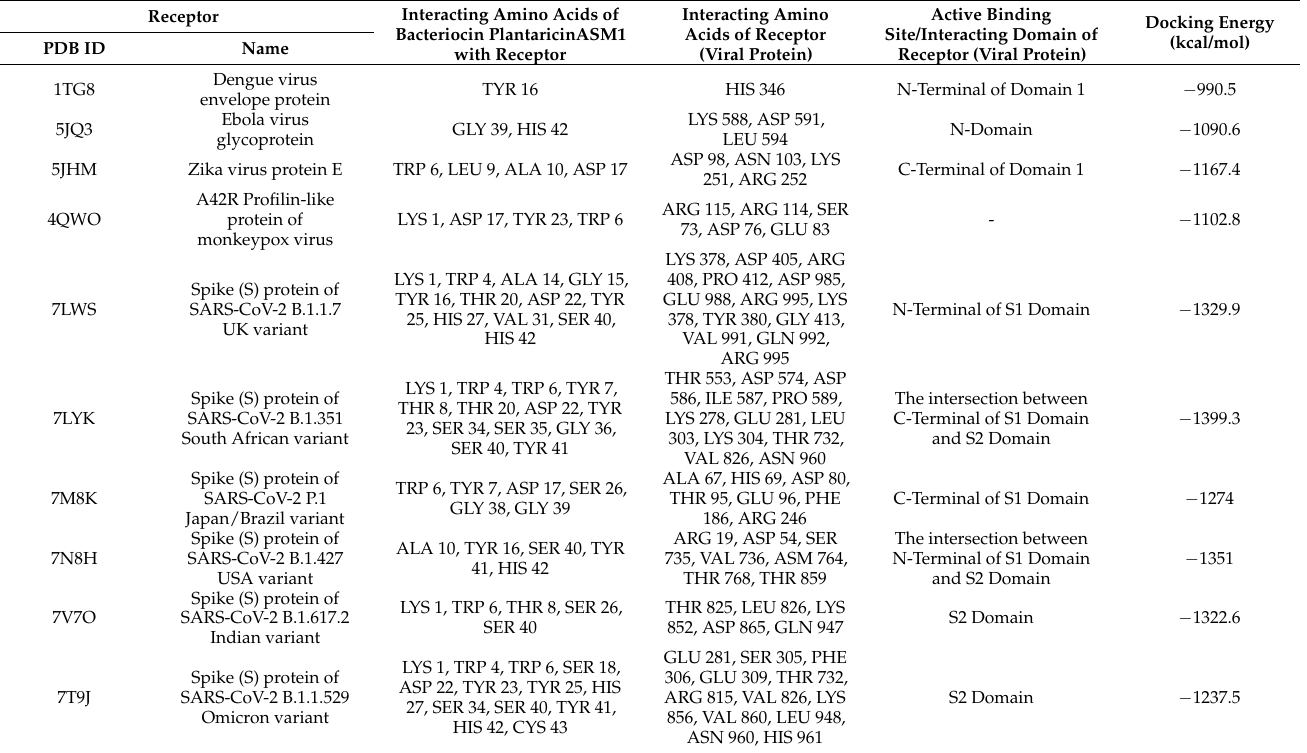
Table 3. Molecular docking analysis of bacteriocin plantaricin ASM1 (PDB ID: 2MVI) derived from L. plantarum .